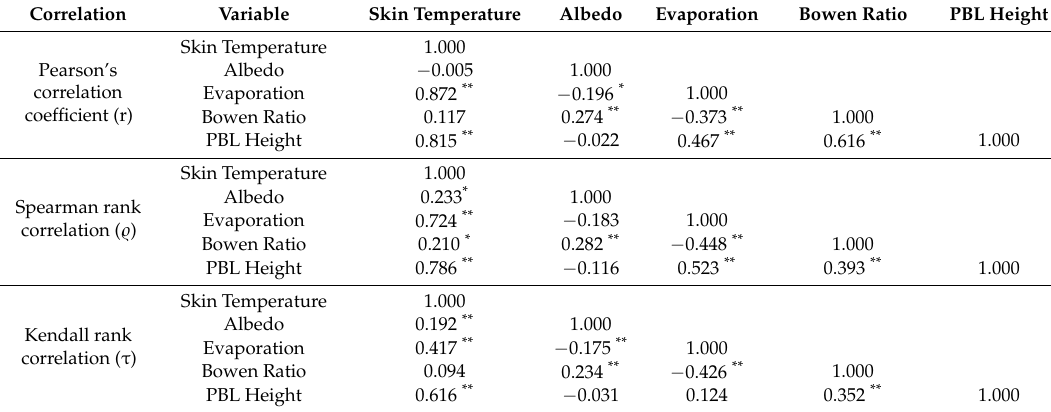
Table 3. Parametric (Pearson’s r) and non-parametric (Spearman’s (cid:36) and Kendall’s τ ) correlation for ERA-Interim derived variables in L1 transect. Number of samples = 108.